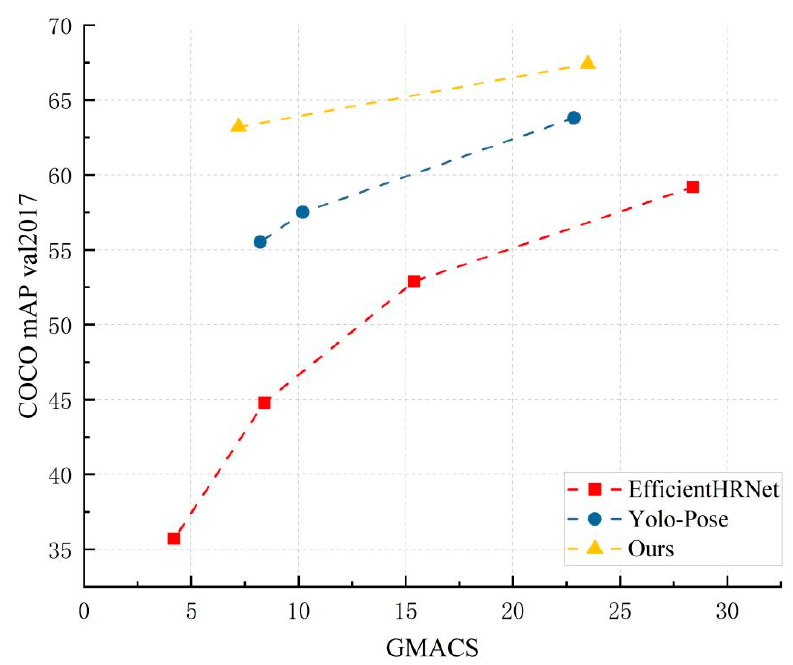
Figure 7. mAP vs. GMACS for Low Complexity Models on COCO 2017 Validation Dataset.